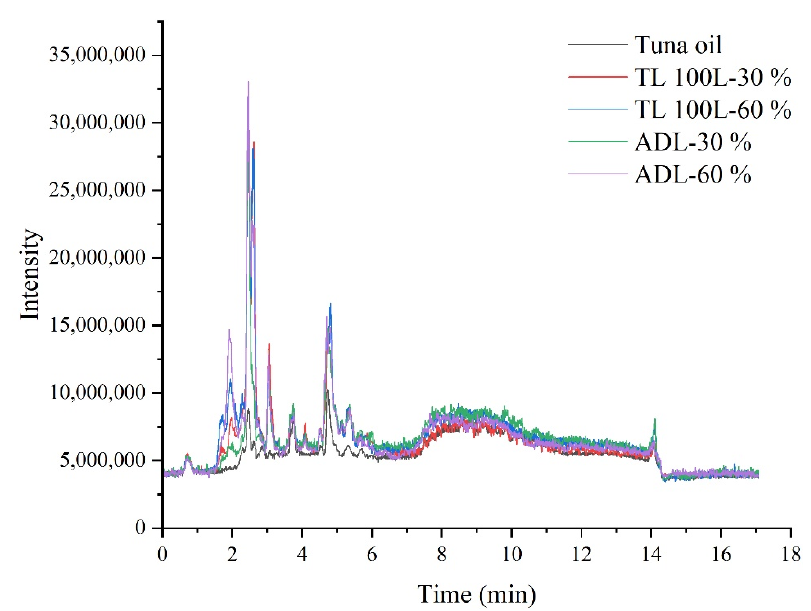
Figure A1. UPLC-Q-TOF-MS negative ion mode of five samples.